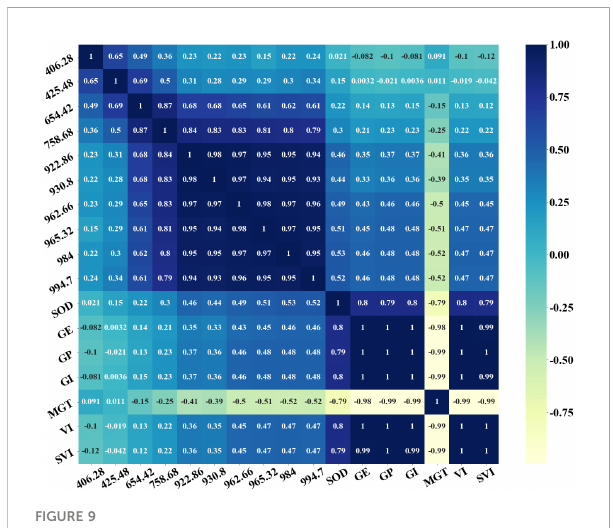
FIGURE 9 Characteristic bands, vitality indicators and SOD activity heatmap.